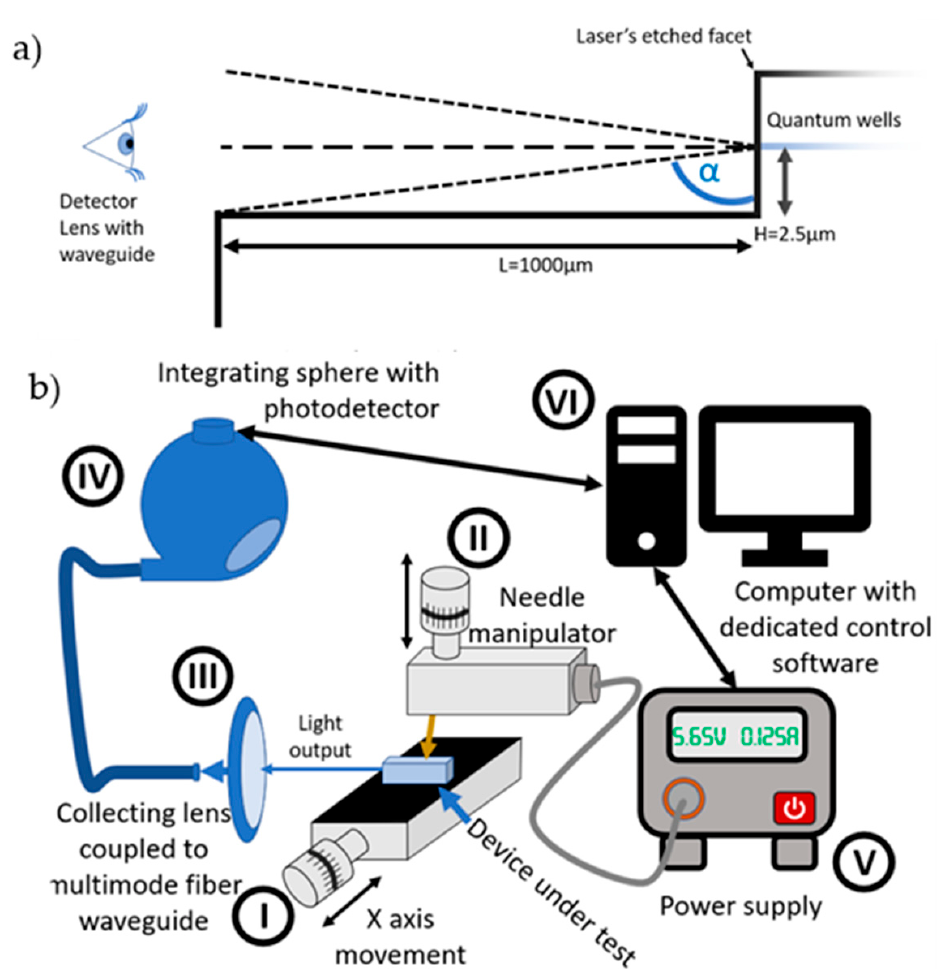
Figure 5. Schematic representations of: ( a ) The geometry of the sample and its effects on reducing light output from a single etched facet chip and ( b ) The opto-electrical testing setup.